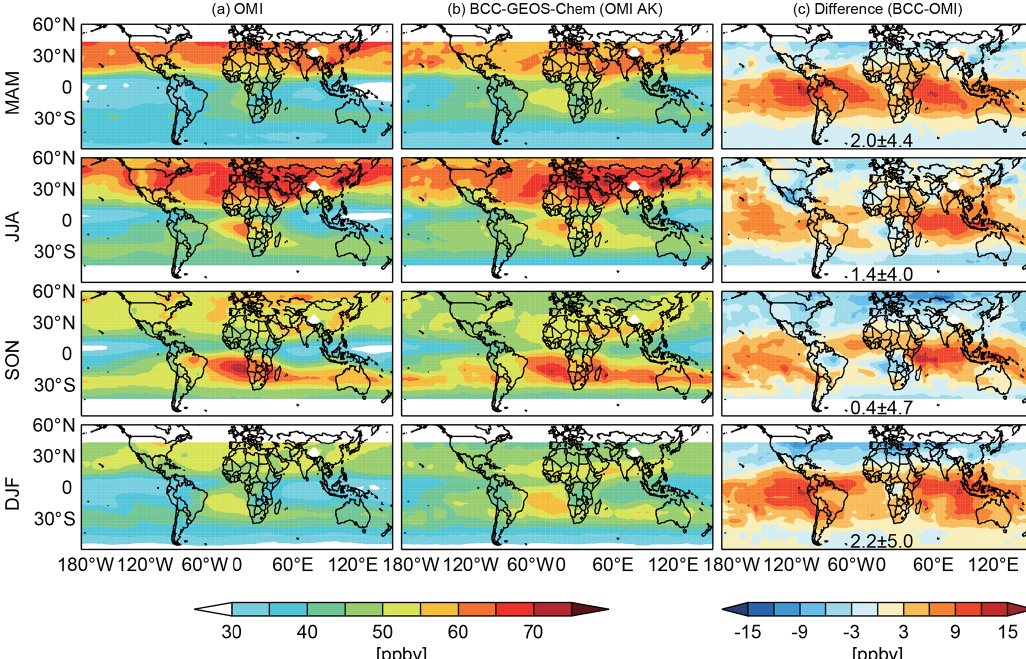
Figure 4. Spatial and seasonal distributions of tropospheric ozone at 700–400hPa from (a) OMI satellite observations, (b) BCC-GEOS- Chem v1.0 model results (with OMI averaging kernels applied), and (c) differences between the two (model results minus observations) with the seasonal mean differences ( ± standard deviations) shown inset. Values are 3-year averages over